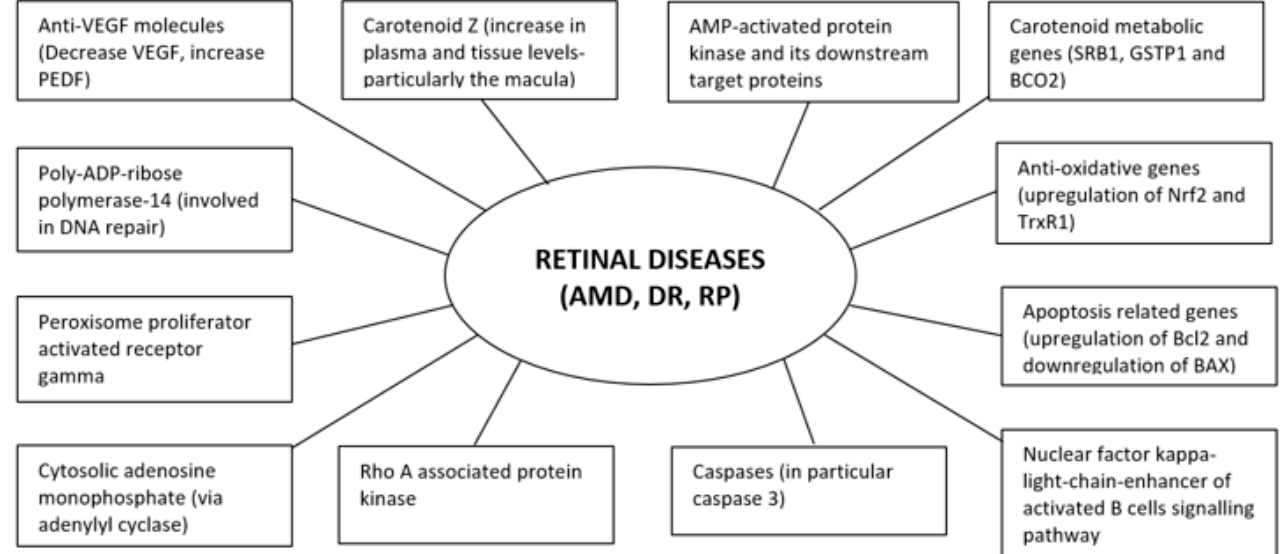
Figure 3. Molecular targets of F lycii in amelioration of retinal diseases.